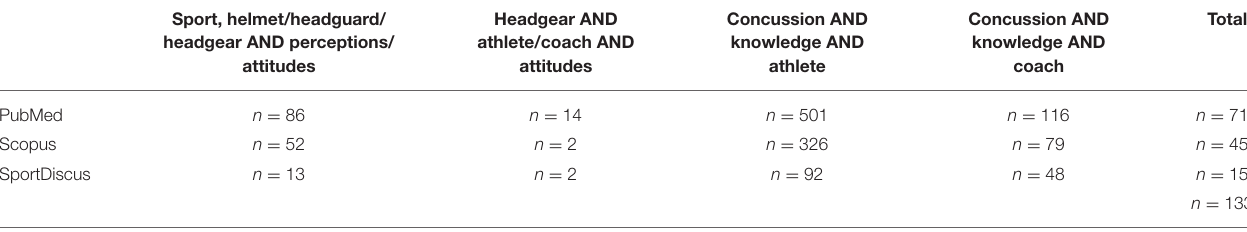
TABLE 2 | Studies identified as relevant to the initial inclusion criteria in the three databases before removing duplicates. Sport, helmet/headguard/ headgear AND perceptions/ attitudes